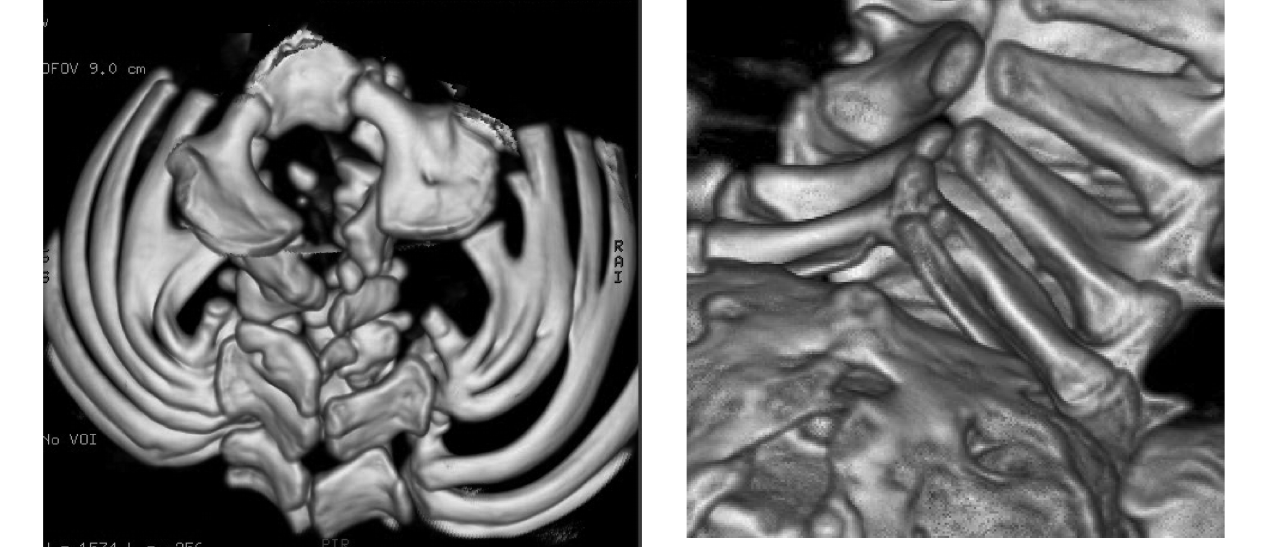
Figure 8 - A 3 D reformatted CT scan showed Spin bifida occulta and extensive malsegmentation along the posterior spine ele- ments are associated with bilateral rib intrinsic anomalies includ- ing partial fusion, broadening, and bifid rib in the same child.